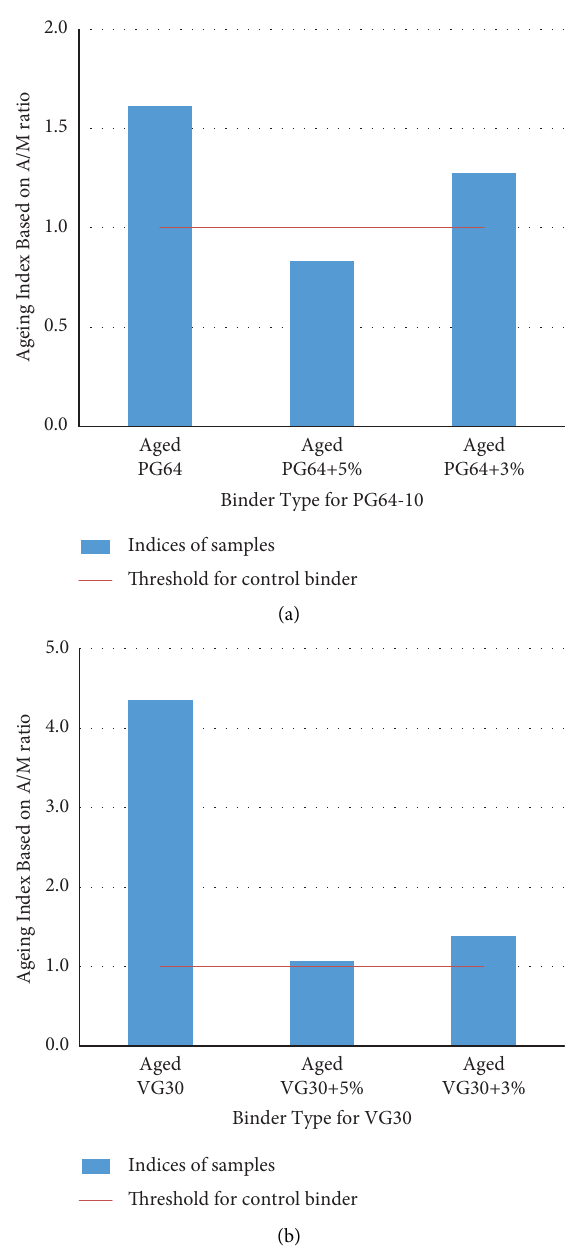
Figure 11: Ageing indices ratio for bitumen binders based on chemical parameters. (a) Binder type for PG64-10. (b) Binder type for